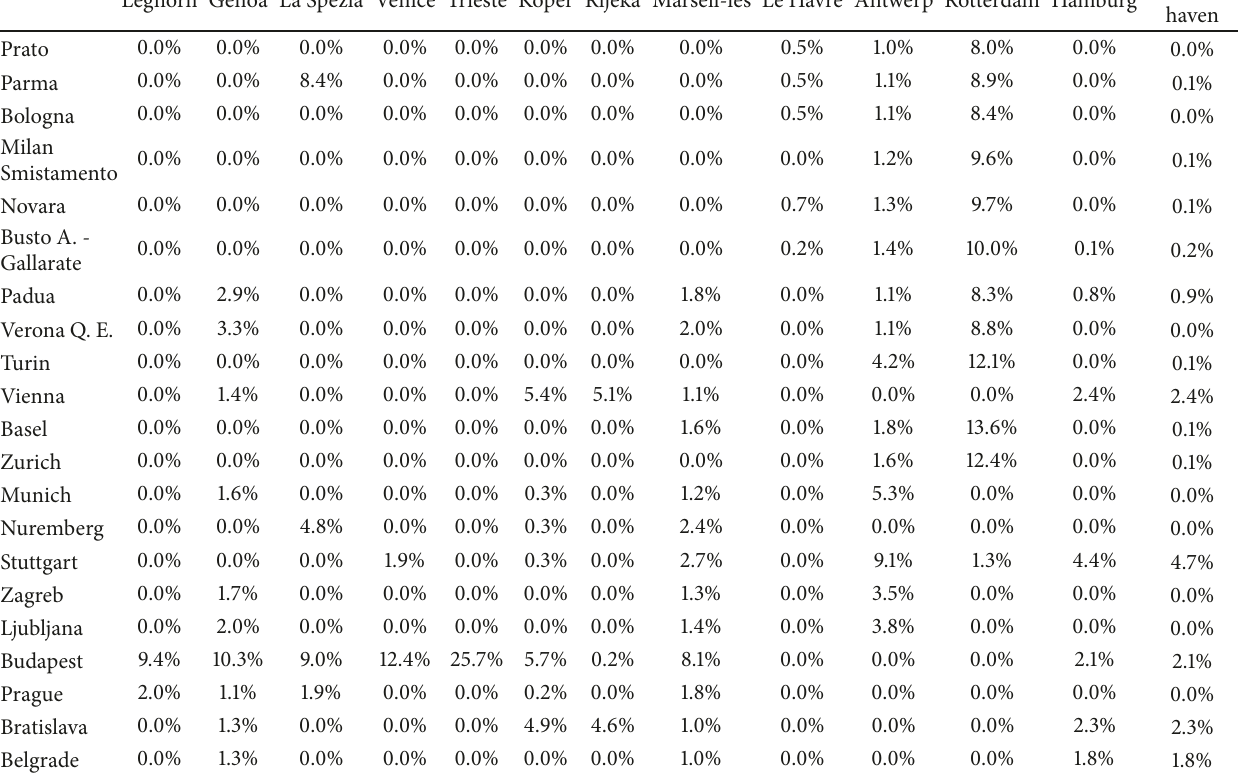
Table 6: Differences, in percentage,of monetary costs, between the optimisation by monetary costs and the optimisation by travel times (the optimisation by monetary costs is taken as